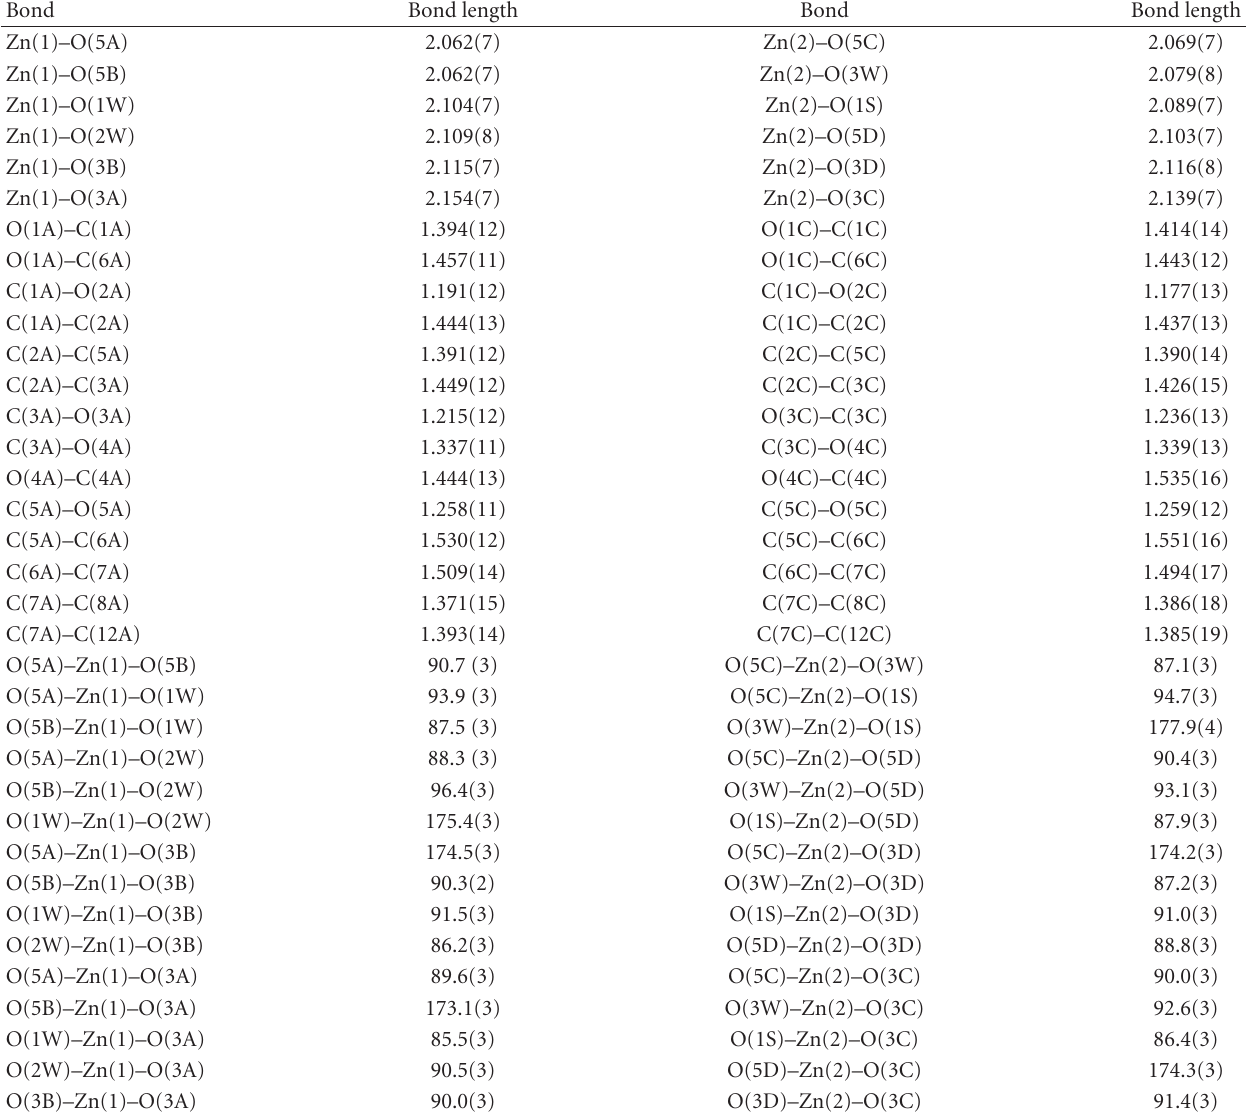
Table 2: Selected bond lengths [˚A] and angles [ ◦ ] for [Zn(L–H) 2 (H 2 O) 2 ][Zn(L–H) 2 (H 2 O)(MeOH)]H 2 O.